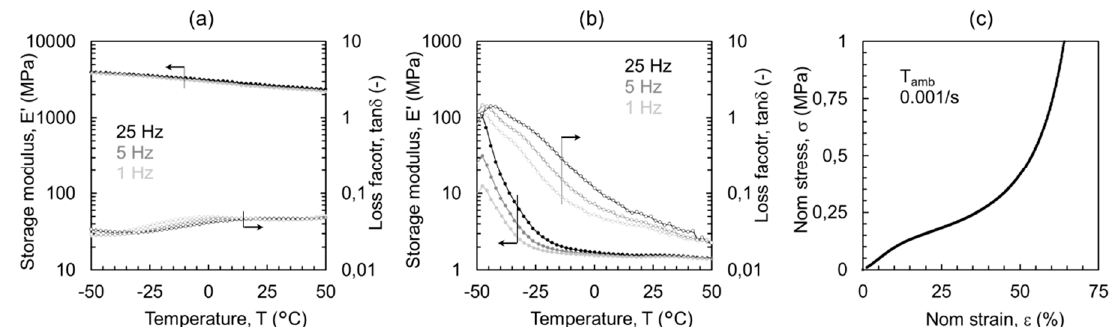
Figure 8. ( a ) Isochronal dynamic mechanical analysis (DMA) profiles of the ball parent material in the [ − 50; 50] ◦ C temperature range. ( b ) Isochronal DMA profiles of the foam material in the [ − 50; 50] ◦ C temperature range. ( c ) Compression stress strain response of the foam parent material. N.B. This figure is a reproduction of Figure 3 in [22].